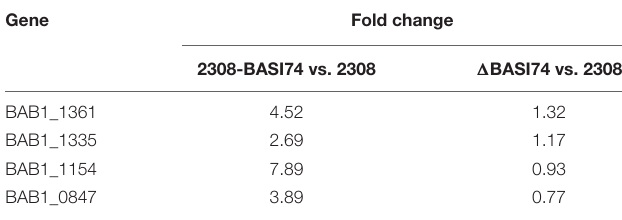
TABLE 4 | The transcriptional levels of four verified target genes in 2308-BASI74 and (cid:49)